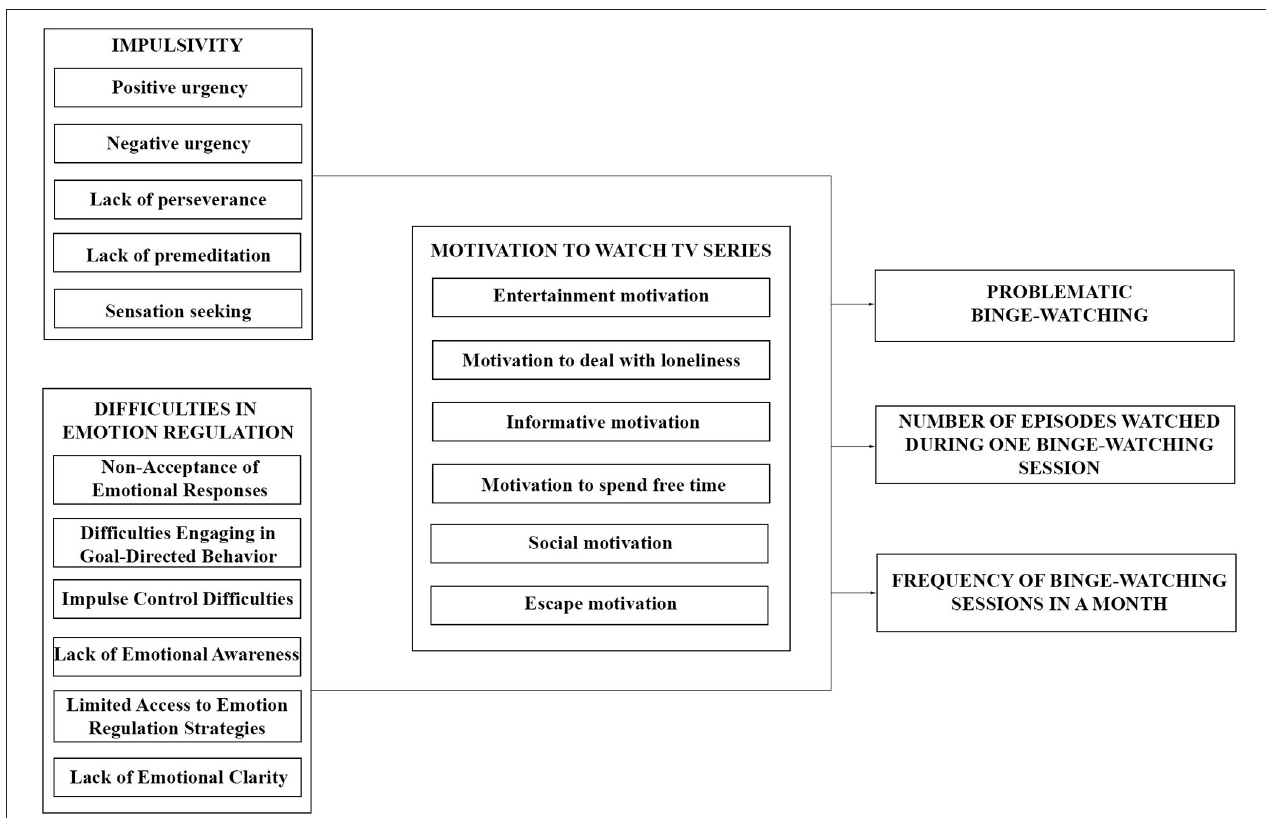
FIGURE 1 | Research